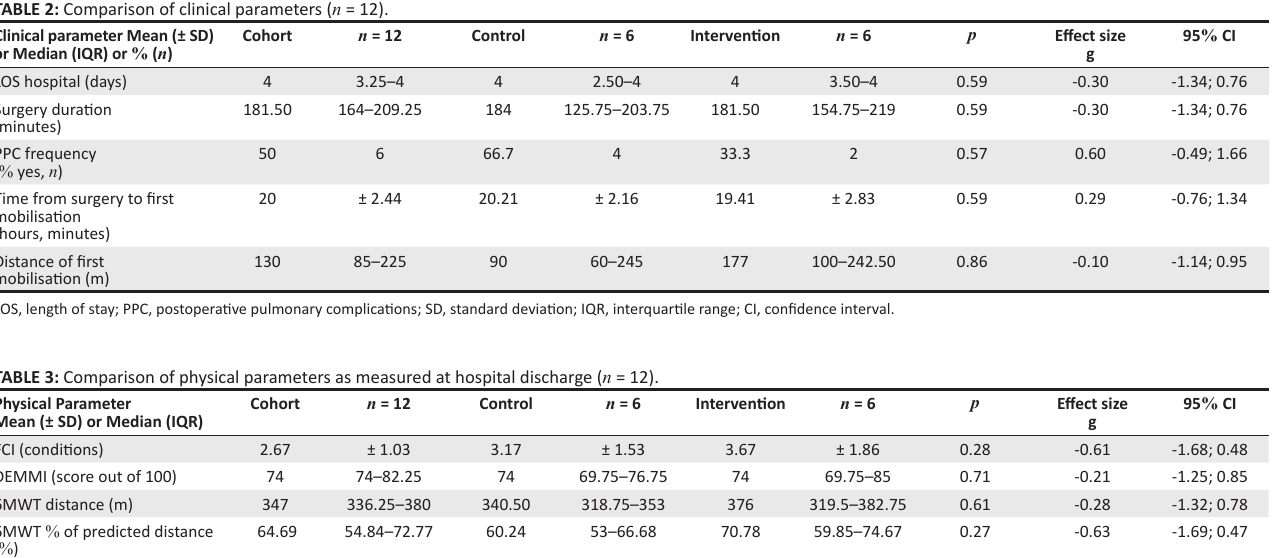
6MWT distance (m)